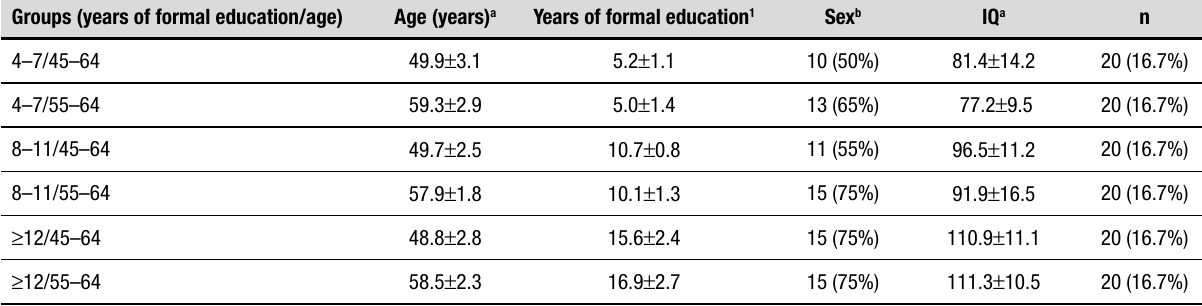
Table 2. Sociodemographic characteristics of the participants.